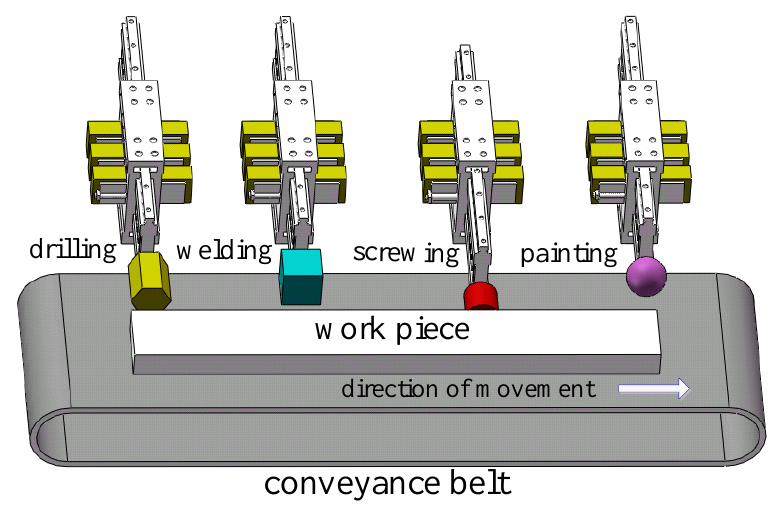
Figure 1. Concept of the processing